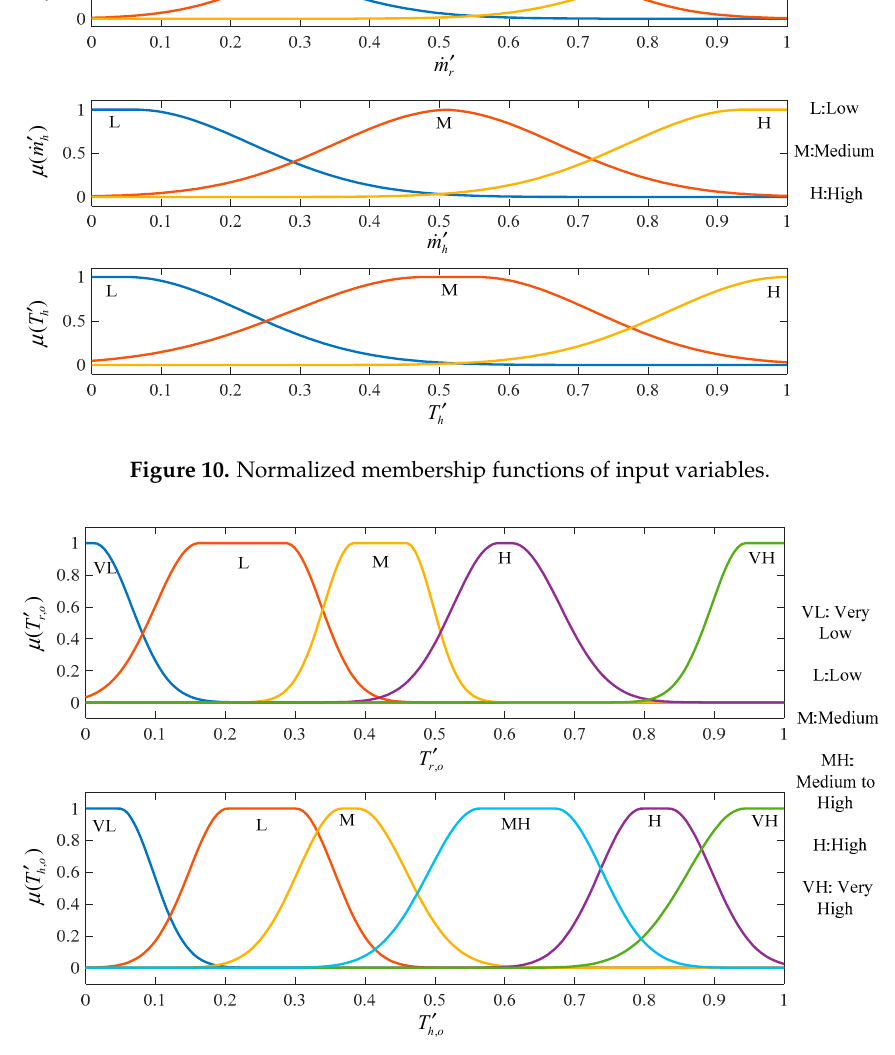
Figure 11. Normalized membership functions of output variables.